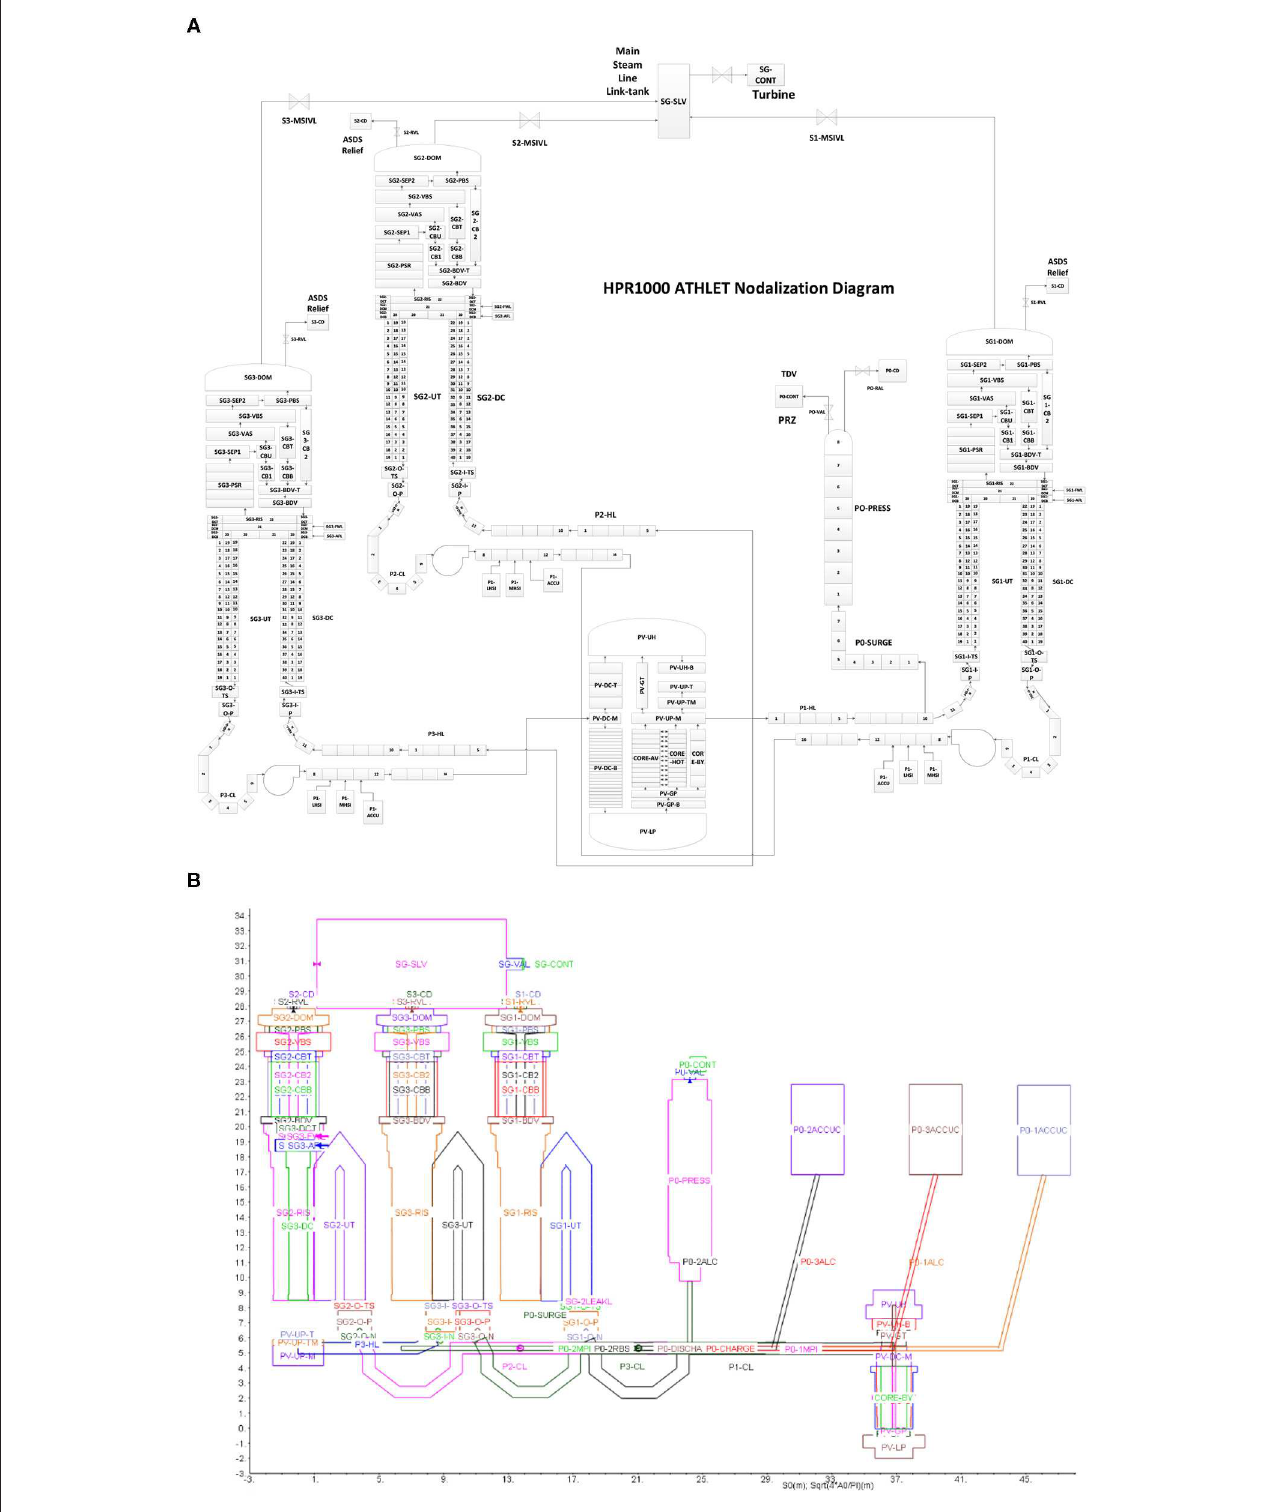
FIGURE 4 | (A) Nodalization diagram for HPR1000 with ATHLET. (B) Graphical representation of HPR1000 ATHLET input data.